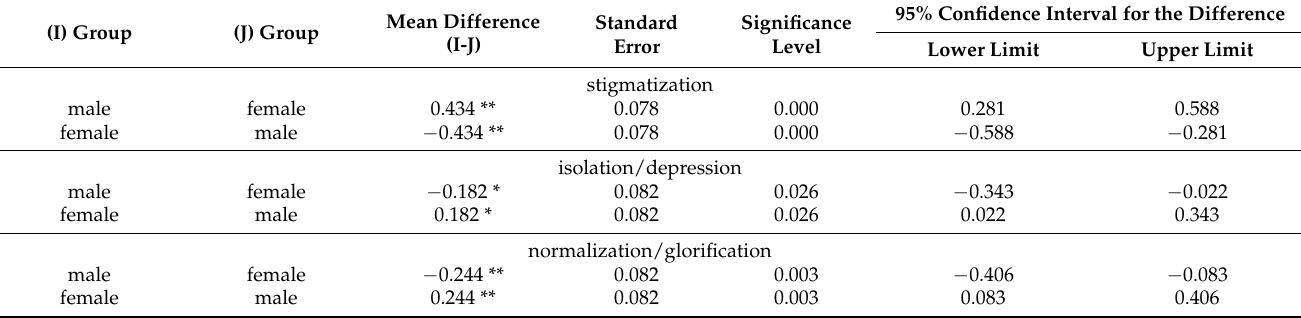
Table 3. Results of the pairwise comparisons according to the Bonferroni test of the two gender groups (post hoc of the MANCOVA) regarding the sum scores for the “stigmatization”, “isolation/depression” and “normalization/glorification” scales of the